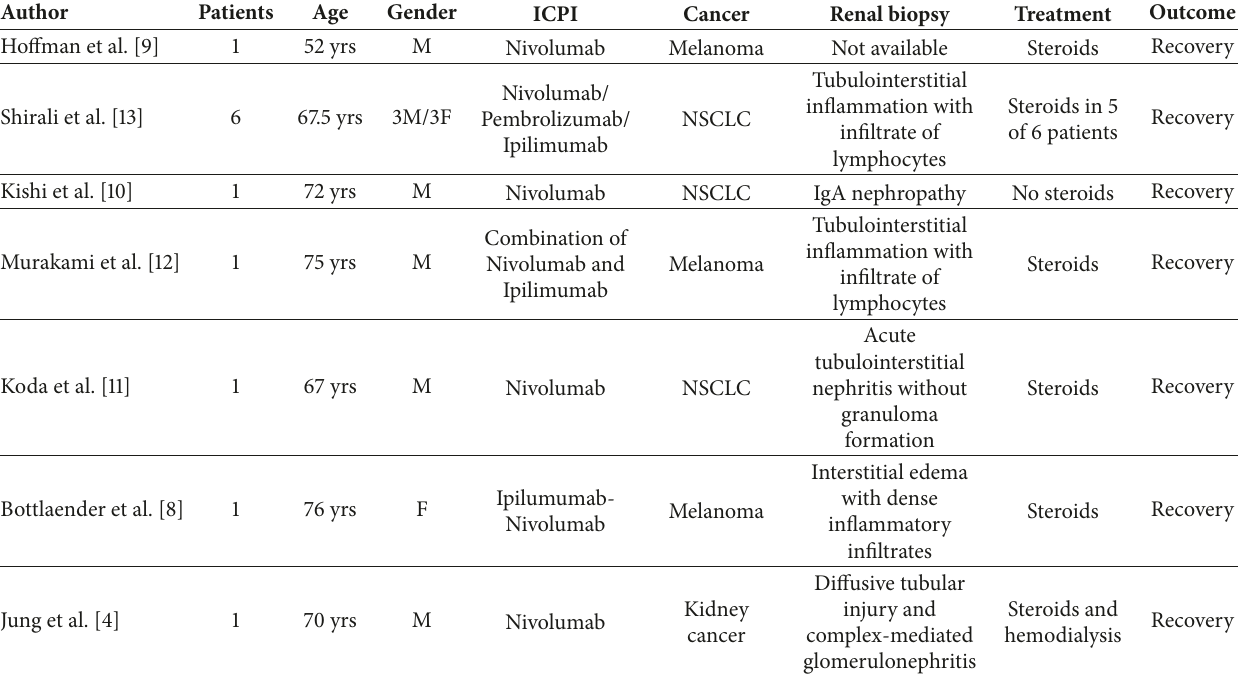
Table 2: Case reports associating nivolumab therapy with nephrotoxic